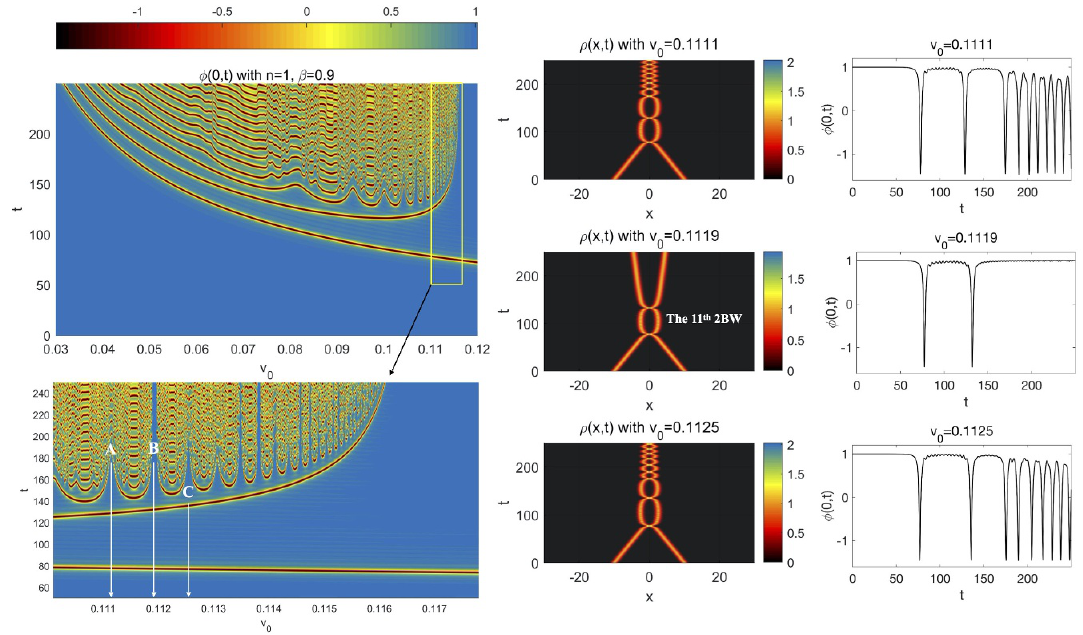
Figure 7 . Plot of (cid:30) ( x = 0 ; t ) as a function of v 0 for n = 1 and (cid:12) = 0 : 9. Under this parameter setting, the critical velocity is v c (cid:25) 0 : 116, and the widest two bounce window lies around v 0 (cid:25) 0 : 112, which is the eleventh two bounce window. Since some higher-order two bounce window (the